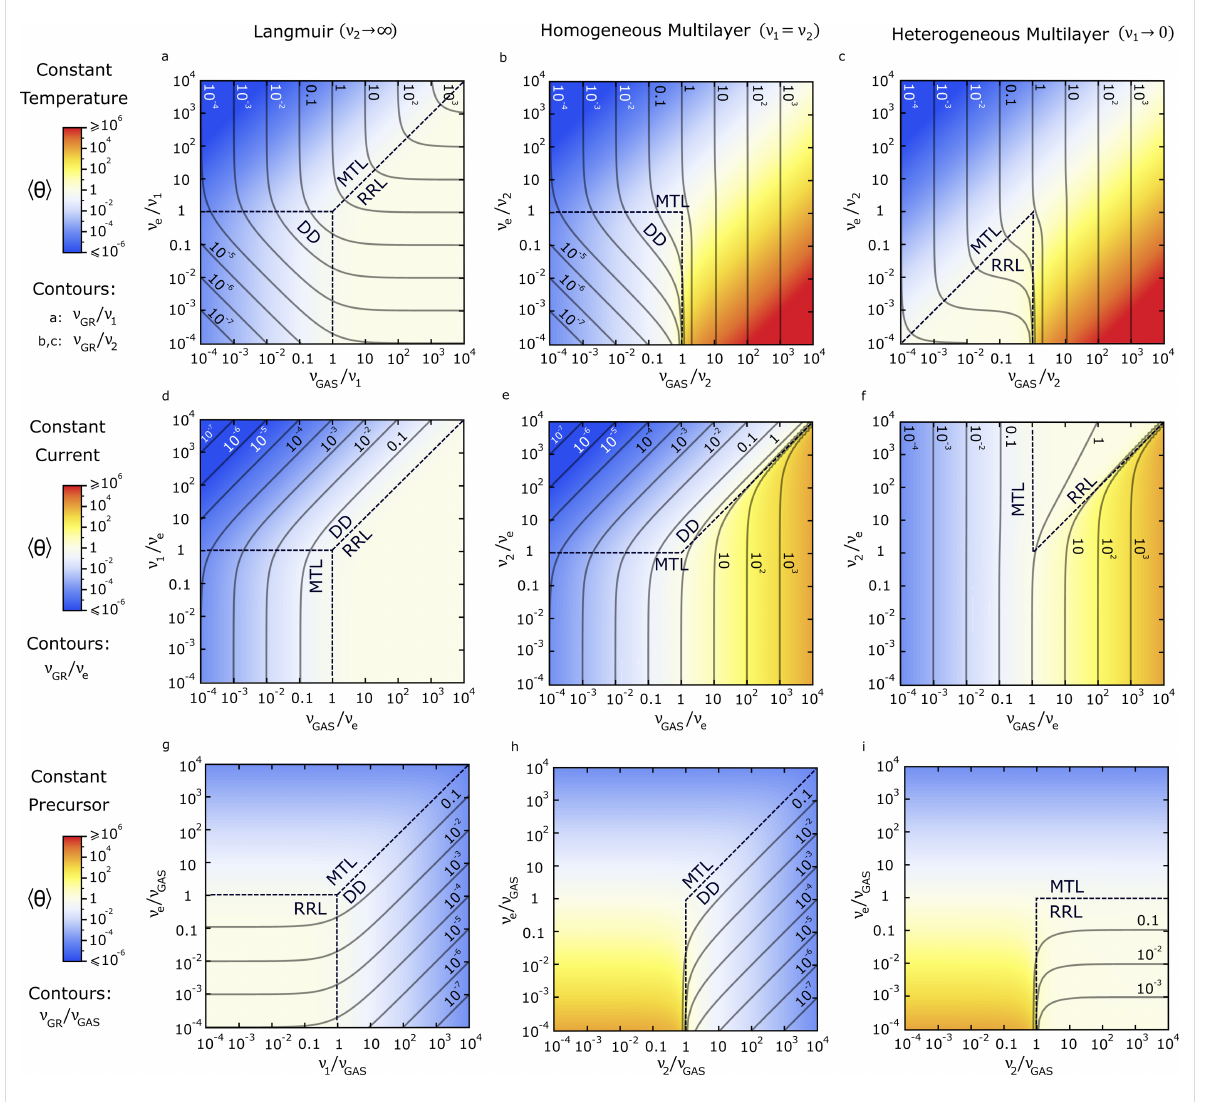
Figure 3: FEBID maps representing growth rate (contours) and adsorbate concentration (colours) for steady state conditions, as a function of the characteristic frequencies ruling a FEBID process. Different growth regimes are indicated for each region. Maps for constant temperature (a–c), cur- rent (d–f) and precursor flux (g–i) conditions are given. The Langmuir model (a, d, g), and the ML model with homogeneous adsorption (b, e, h) and heterogeneous adsorption (c, f, i) are